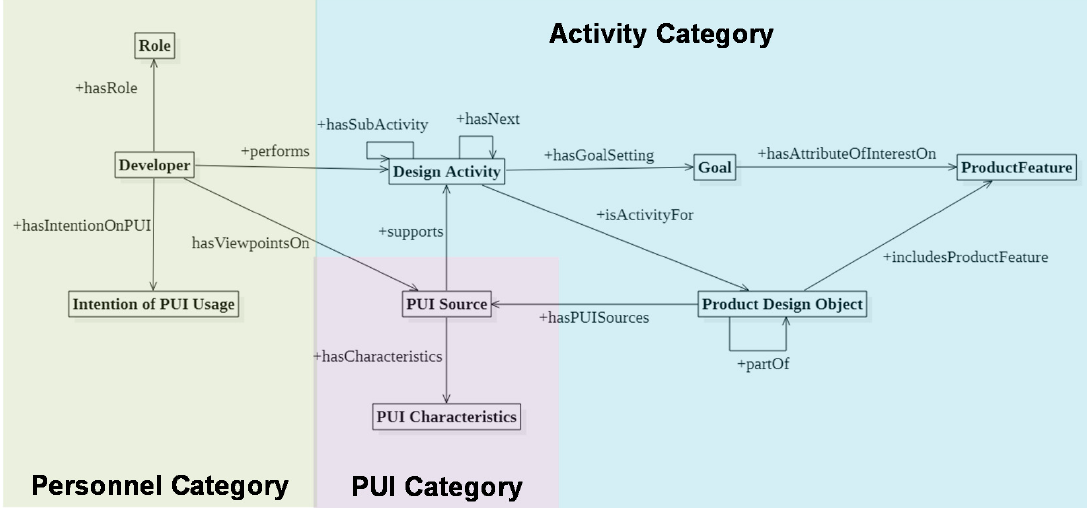
Figure 3. Upper-level conceptual diagram of the product development task model. Table 2. Overview of key elements in the product development task model.